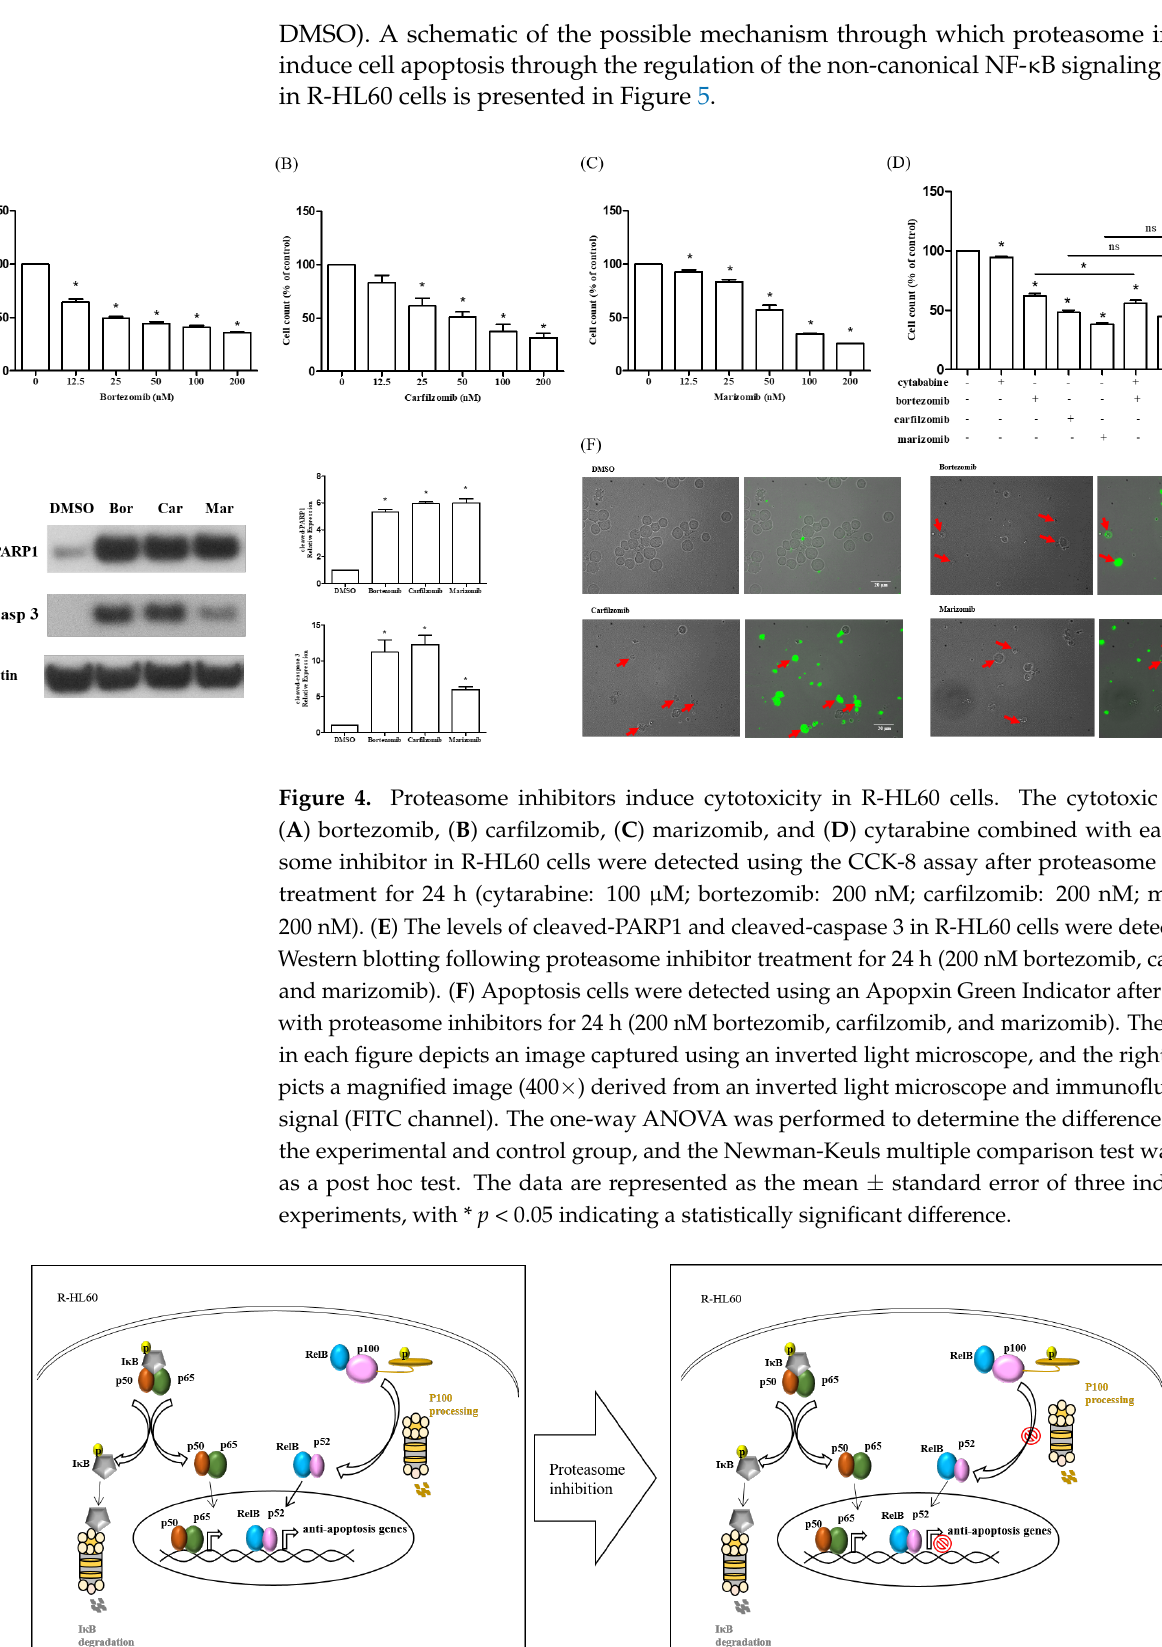
Figure 5. A schematic of the possible mechanism through which proteasome inhibitors induce cell apoptosis through regulation of the non-canonical NF- κ B signaling pathway in R HL60